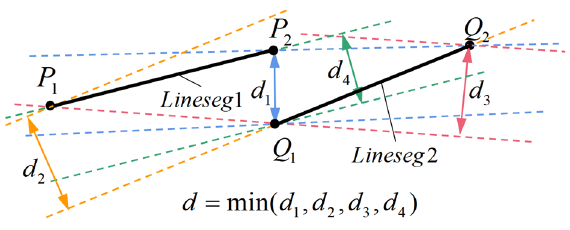
Figure 12. Diagram of Line Segment